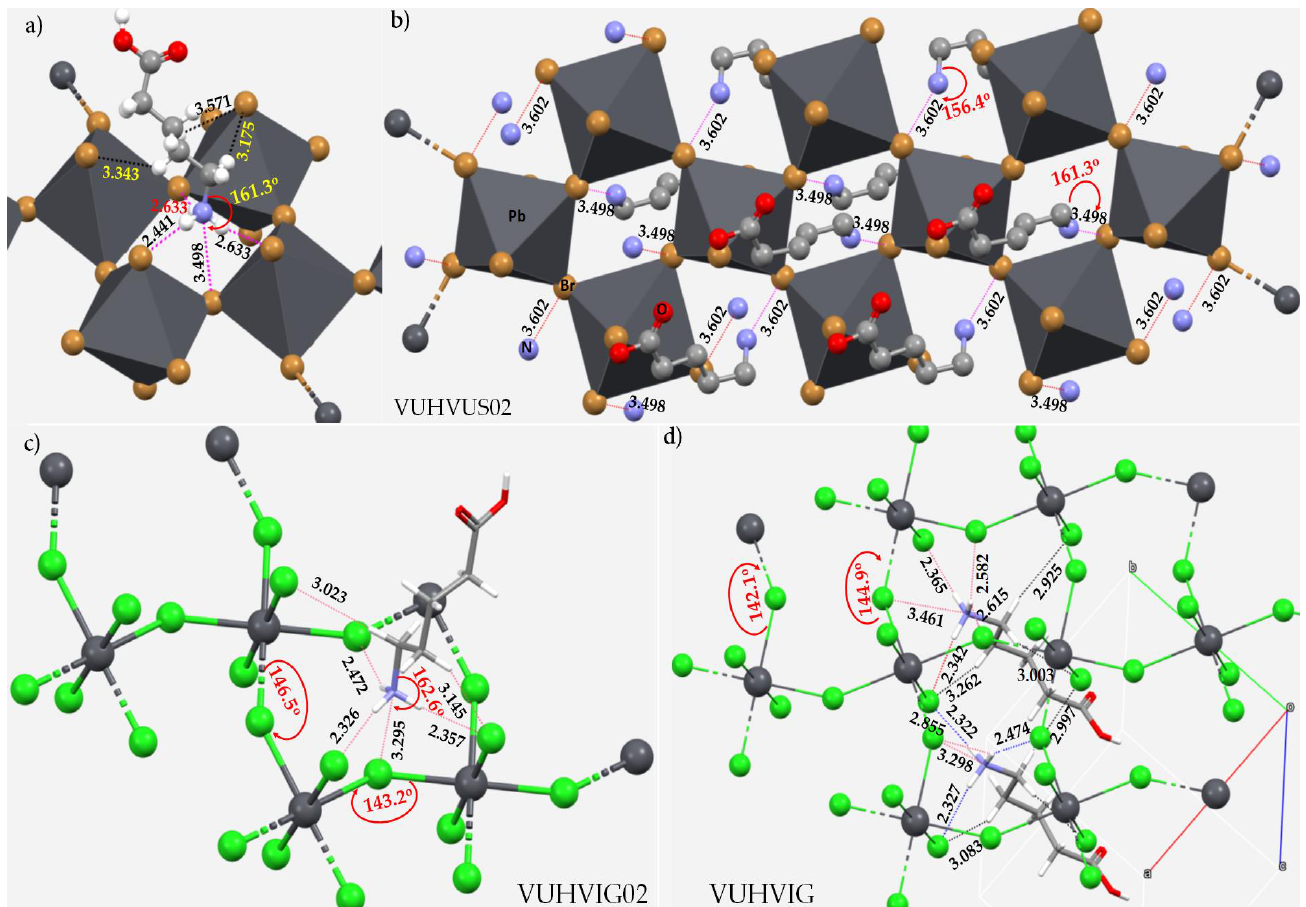
Figure 22. ( a , b ) The polyhedral ball-and-stick models of [HOOC(CH 2 ) 4 NH 3 ] 2 PbBr 4 [147] showing ( a ) the nature of N – H···Br and C – H···Br hydrogen bonding and N···Br pnictogen bonding interactions, and ( b ) N···Br pnictogen bonding interactions (H atoms omitted), formed at the organic and inorganic interface. ( c , d ) The crystal structure of [HOOC(CH 2 ) 4 NH 3 ] 2 PbCl 4 (CSD refs. VUHVIG02 [109] and VUHVIG [148]) showing the nature of N – H···Cl and C – H···Cl hydrogen bonding and N···Cl pnictogen bonding interactions formed at the organic and inorganic interface. Selected bond dis- tances and bond angles are in Å and degrees, respectively.